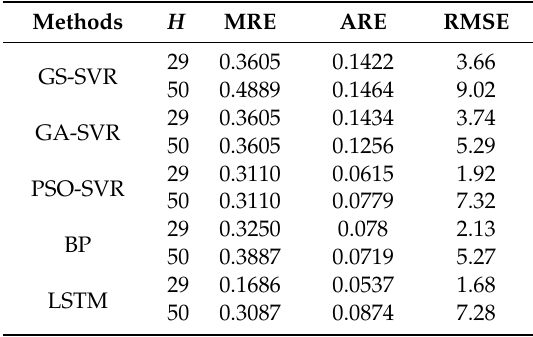
Table 4. The prediction error comparisons based on di ff erent